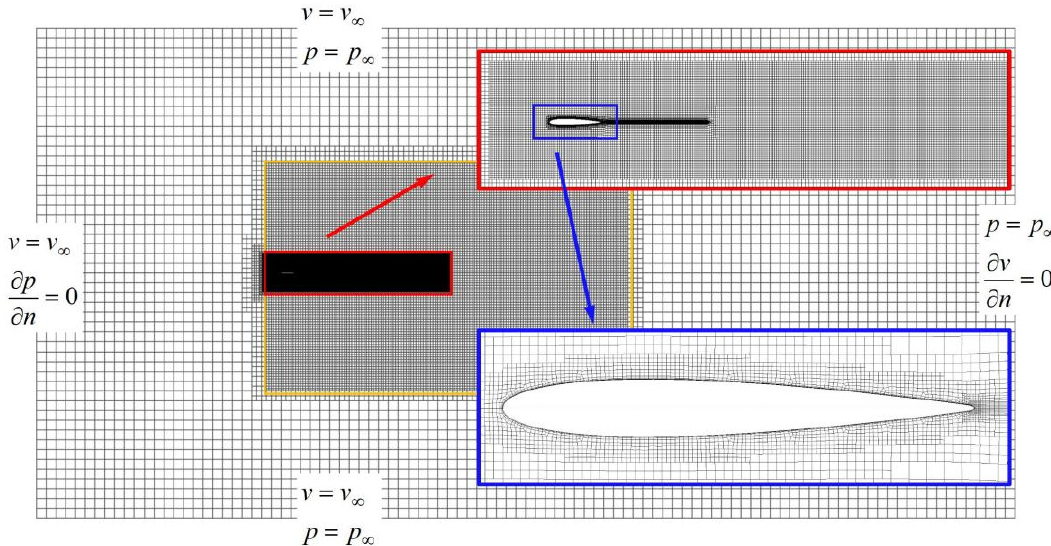
Figure 6. Schematic diagram of computational domain and gradual mesh refinement.